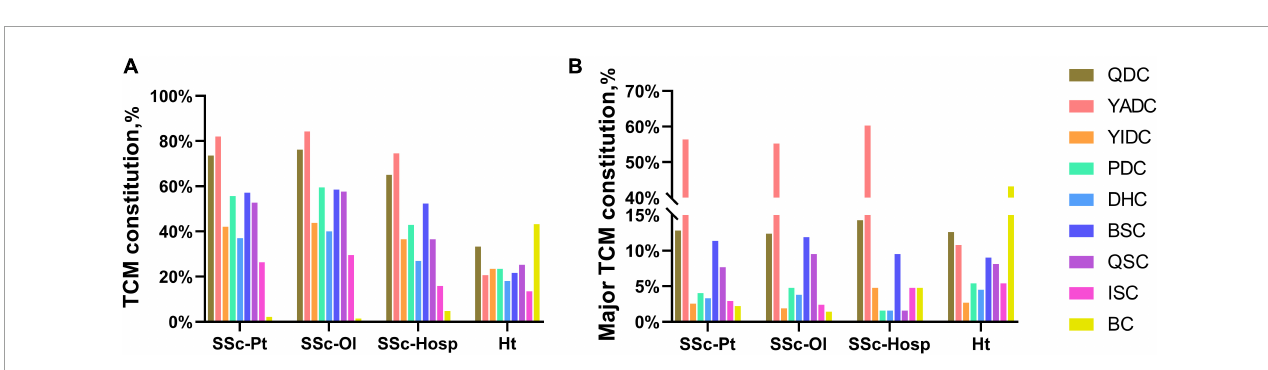
FIGURE3 Traditional Chinese Medicine (TCM) constitution rate. (A) TCM constitution. (B) Major TCM constitution. SSc-Pt, systemic sclerosis patients; SSc-Ol, online systemic sclerosis patients; SSc-Hosp, hospital systemic sclerosis patients; Ht, healthy person; BC, balanced constitution; YADC, Yang-deficiency constitution; YIDC, Yin-deficiency constitution; QDC, Qi-deficiency constitution; QSC, Qi-stagnation constitution; PDC, phlegm-dampness constitution; DHC, Dampness-heat constitution; BSC, blood-stasis constitution; ISC, inherited special constitution; TCM constitution, Traditional